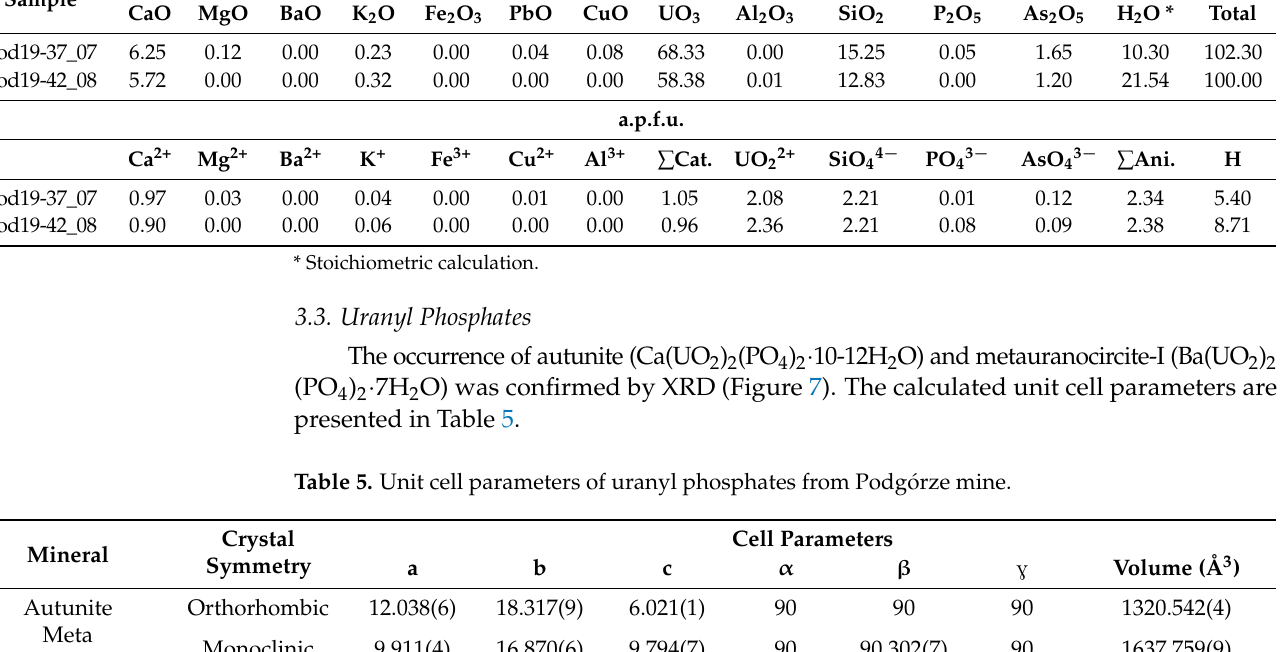
Figure 6. Uranyl silicates from Podg ó rze mine: ( A ) sklodowskite, ( B ) uranophane, and ( C ) uranophane- β . Table 4. Chemical composition of uranophanes from Podg ó rze. Compound (wt. %)